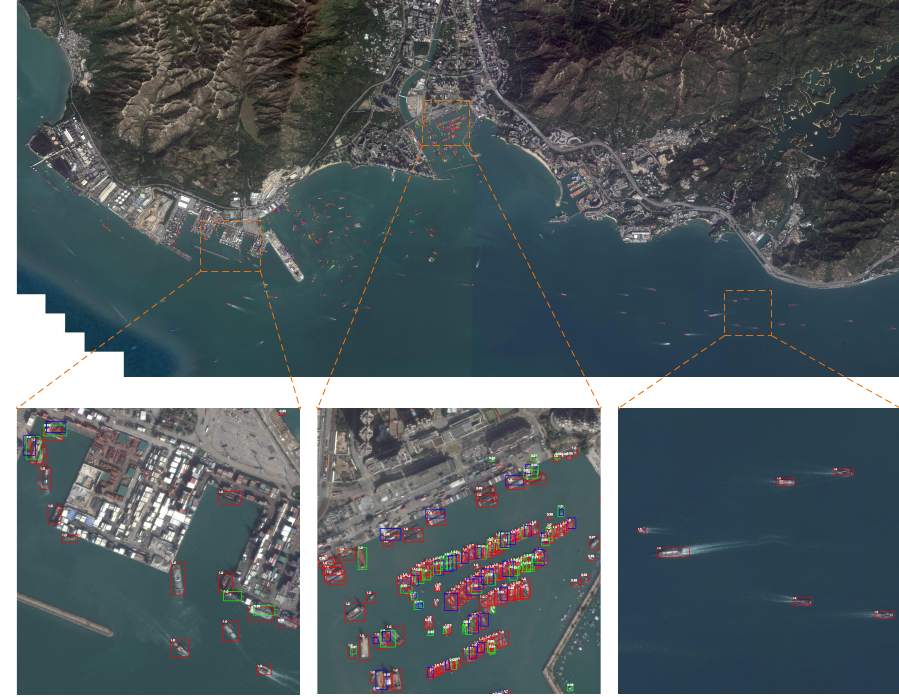
Figure 13. The detection results of IMAGE3. The true positives, false positives and false negatives are indicated by red, green and blue rectangles. The top left corner of the rectangle shows the